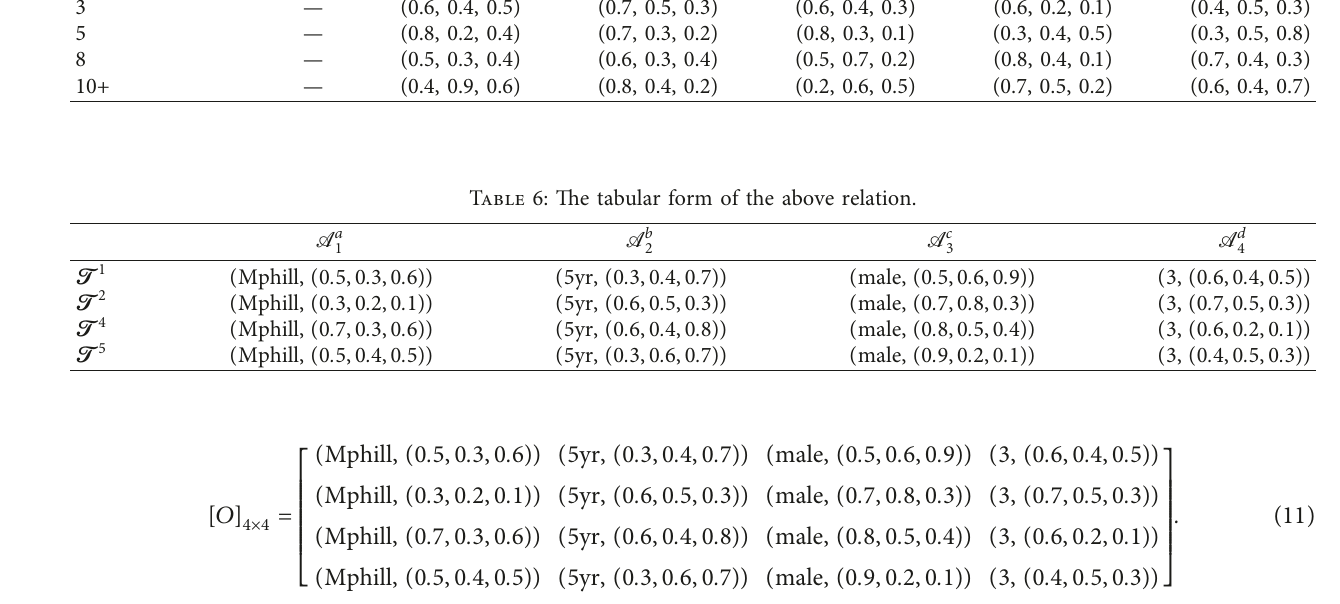
Table 5: Decision makers will assign neutrosophic numbers to each candidate T